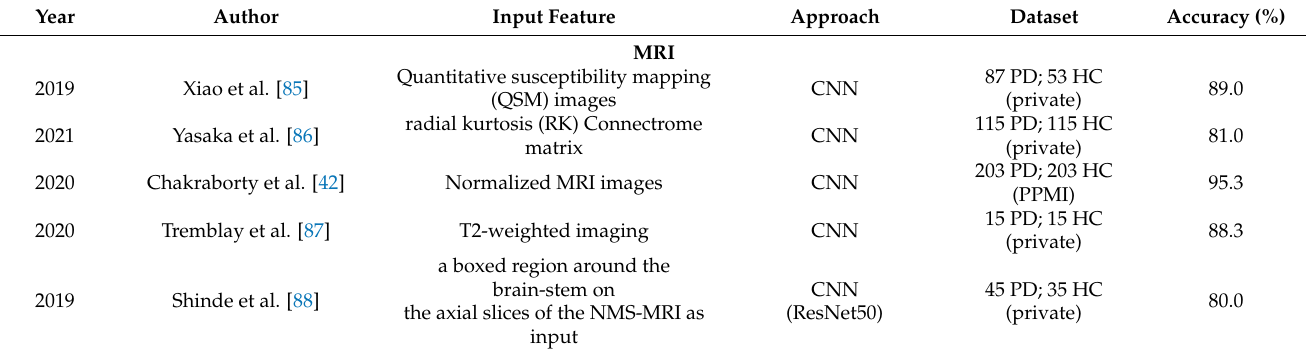
Table A1. List of deep learning studies for various modalities in brain